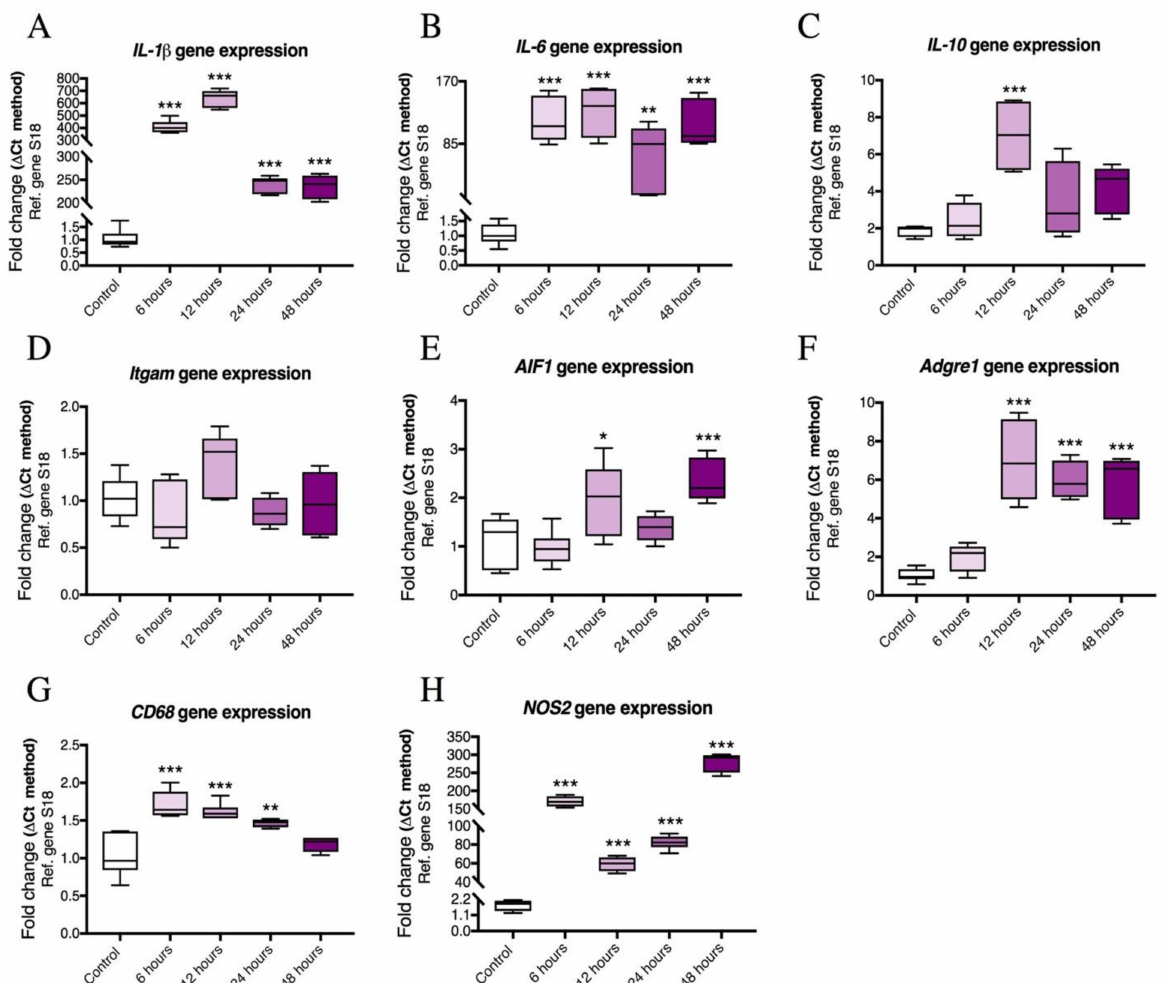
Figure 2. Time-course analyses of the mRNA expression levels of pro-inflammatory markers and cytokines after exposure to LPS. Murine BV2 cells were serum starved for 24 h prior to treatment with 1.0 µ g/mL of LPS for 0, 6, 12, 24 and 48 h. The RNA was extracted by TRISURE reagent and reverse transcribed into cDNA. The mRNA levels of ( A ) IL-1 β , ( B ) IL-6, ( C ) IL-10, ( D ) Itgam, ( E ) AIF1, ( F ) Adgre1, ( G ) CD68 and ( H ) NOS2 were determined by RT-qPCR with S18 as an internal housekeeping gene. Levels were quantified by Delta-CT method. Data represent means of 4—6 samples for each group. Results are expressed as mean ± SEM. * p < 0.05, ** p < 0.01, *** p < 0.001 vs. control as determined by one-way